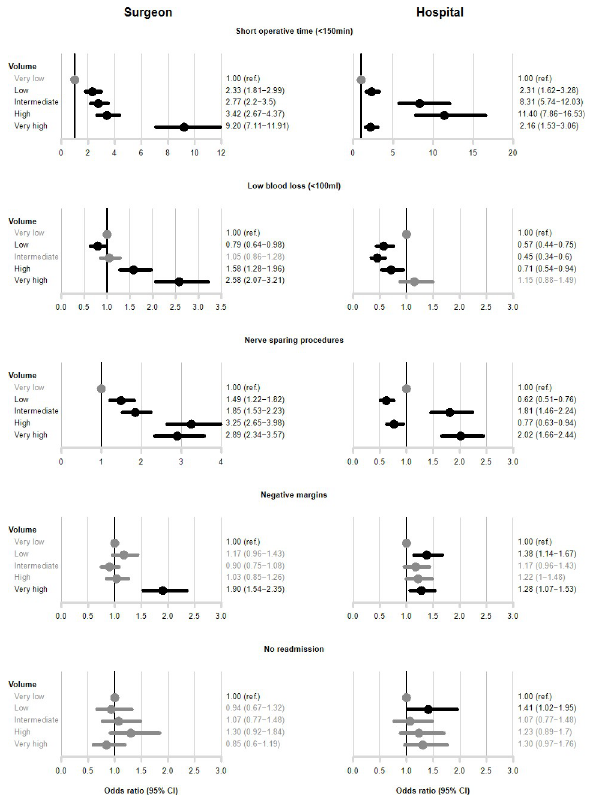
Fig 2. Odds ratios (OR) and 95% confidence intervals (CI) of outcome according to surgical volume by single surgeon and hospital.